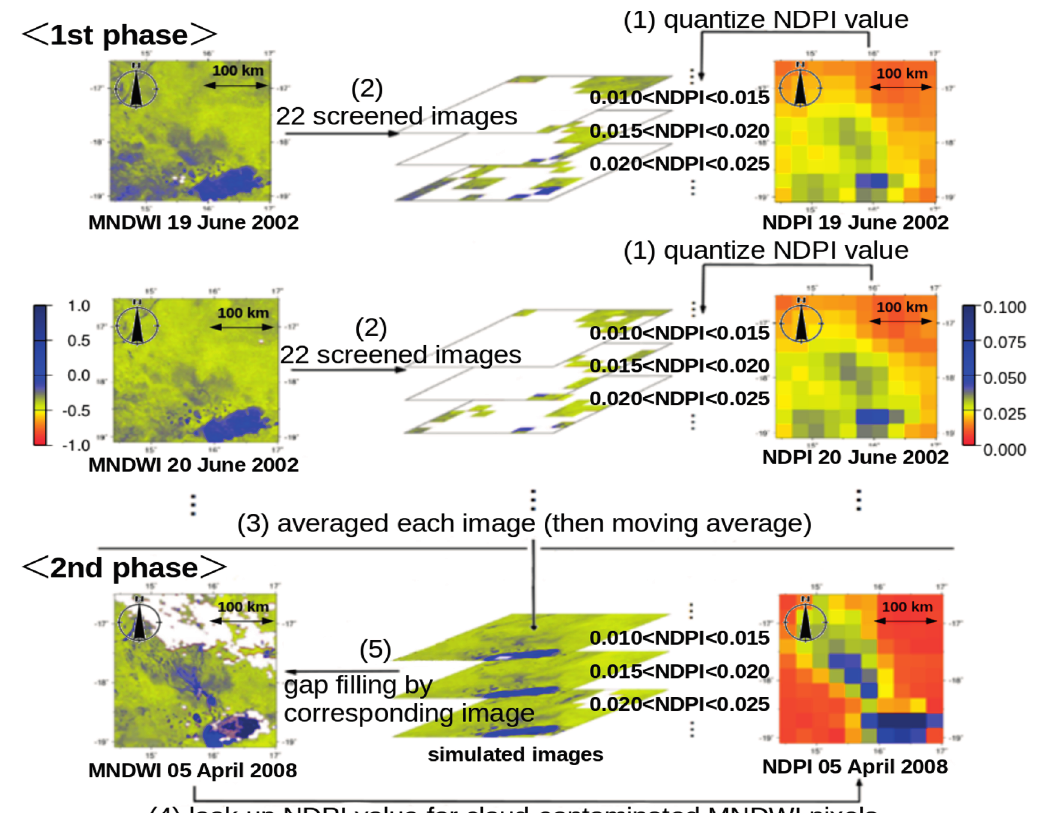
Figure 6. The sequence used for the database unmixing